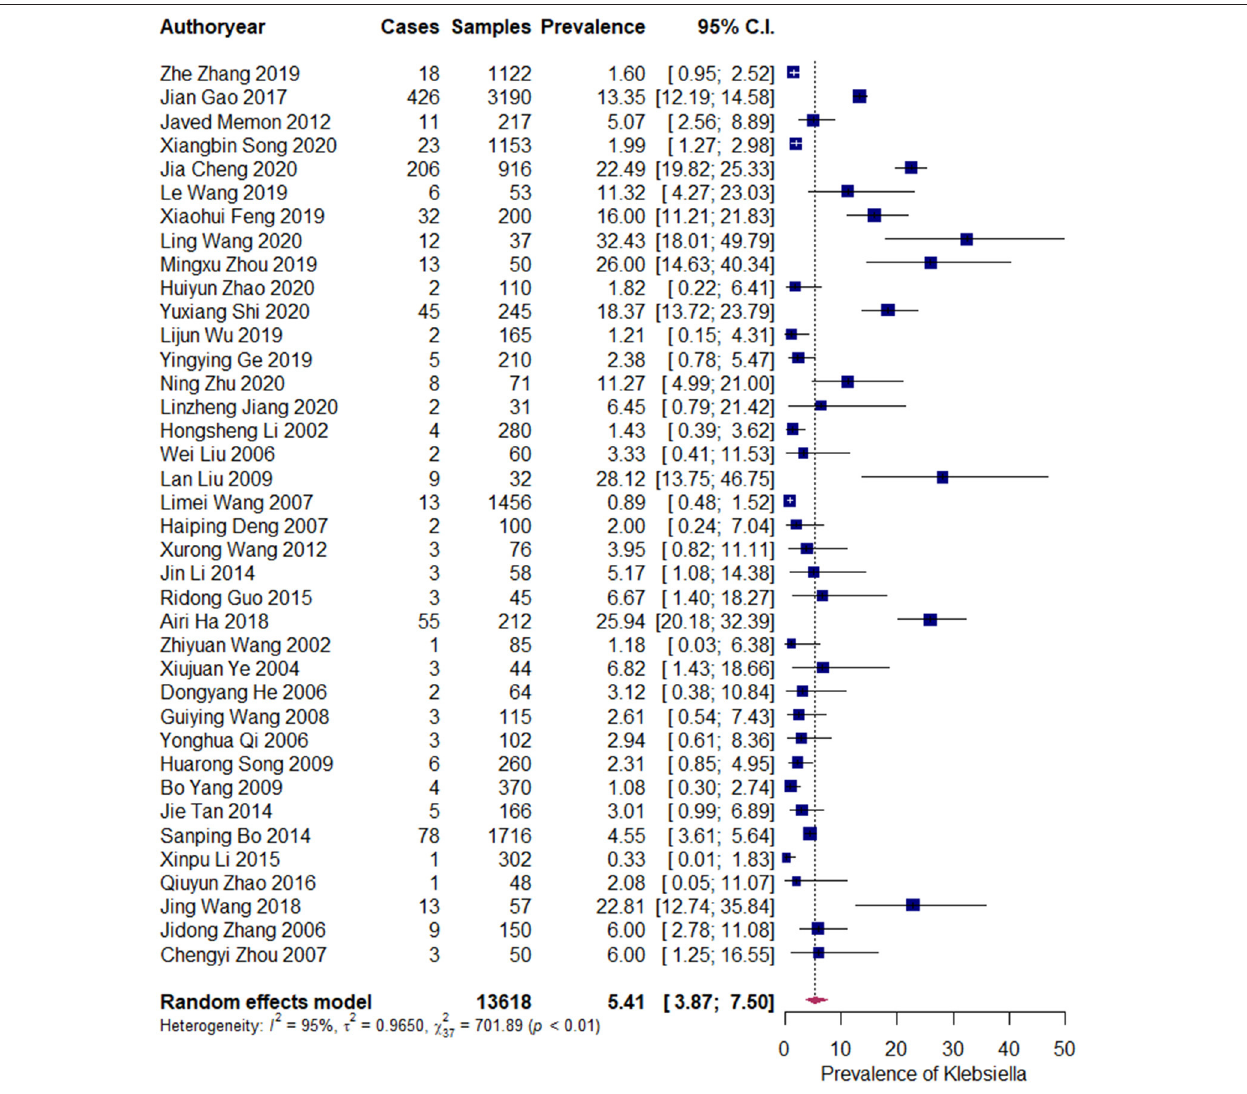
FIGURE 2 | Prevalence of Klebsiella spp. Each navy blue square represents the mean prevalence for a study. The upper and lower limit of the line connected to the square represents the upper and lower 95% CI for the prevalence. The size of the square reflects the relative weighting of the study to the overall prevalence estimate, with larger squares representing greater weight. The broken vertical line represents overall prevalence and the diamond at the bottom represents the overall prevalence (location of the diamond) and its 95% CI (width of the diamond). Cases refers to the Klebsiella spp. containing samples. “Author year” refers to the first author and publication year of the publication (the same